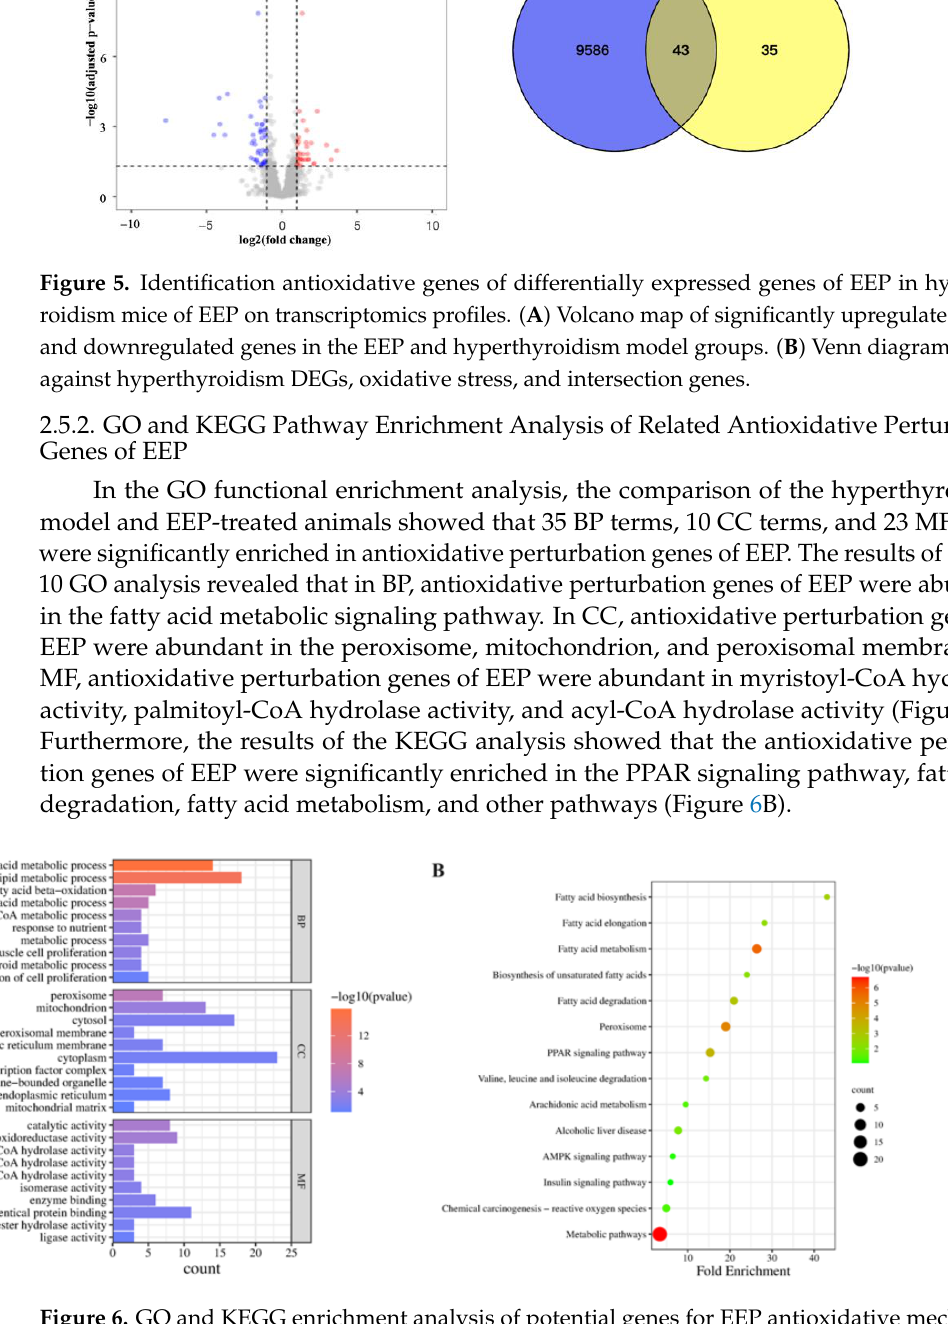
Figure 6. GO and KEGG enrichment analysis of potential genes for EEP antioxidative mechanism against hyperthyroidism of EEP on transcriptomics profiles. ( A ) Bar chart of GO analysis, ( B ) bubble chart of KEGG pathways.